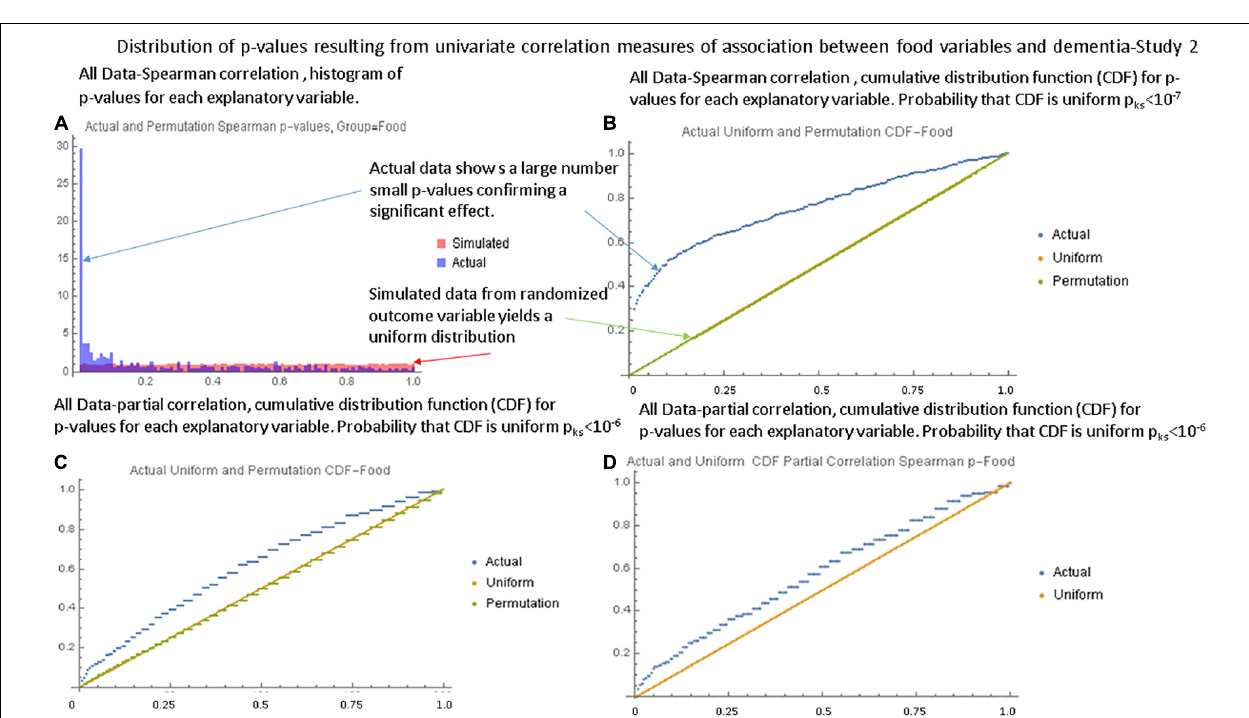
Frontiers in Aging Neuroscience |